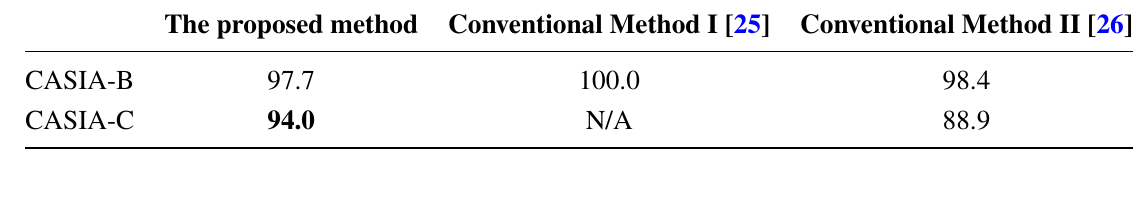
Table 1. Correct classification rates with CASIA-B and CASIA-C by the proposed method and the conventional methods [ %